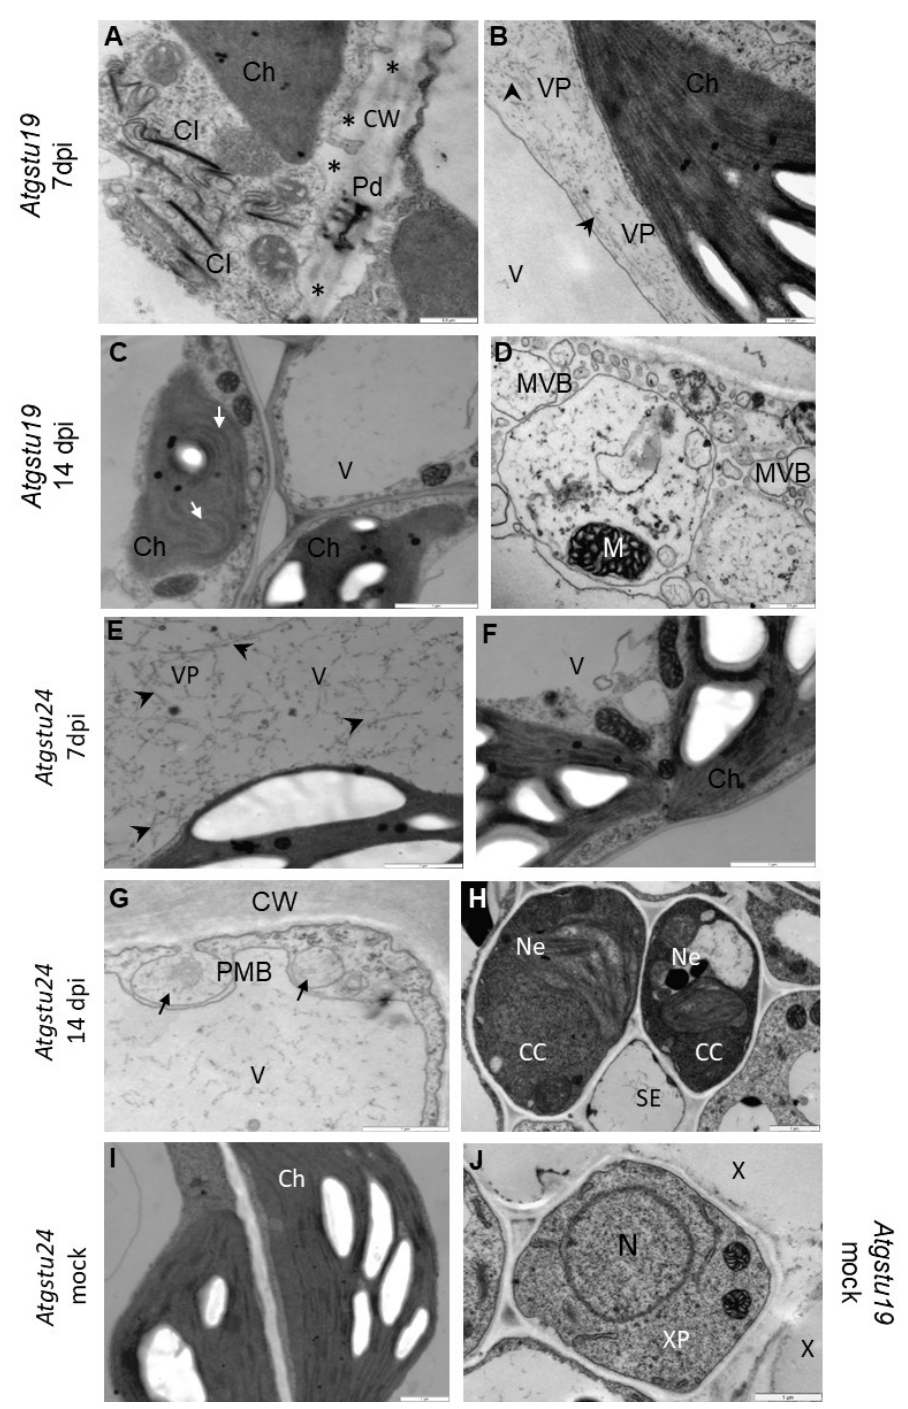
Figure 2. Ultrastructural alterations in Atgstu19 ( A – D ) and Atgstu24 ( E – H ) in response to TuMV at 7 ( A , B , E , F ) and 14 ( C , D , G , H ) days after inoculation and mock inoculated plants ( I , J ). ( A ) TuMV